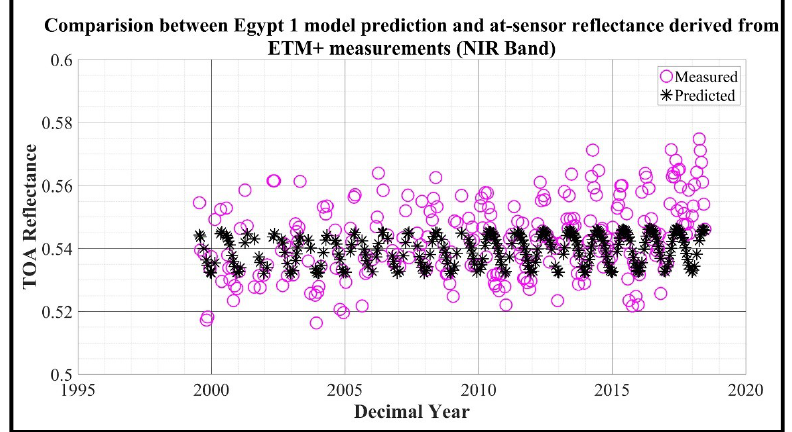
Figure 9. L7 ETM+ observations of Egypt 1(circle) and model prediction (asterisk). Figure 9. L7 ETM + observations of Egypt 1(circle) and model prediction (asterisk). Remote Sens. 2019 , 11 , x FOR PEER REVIEW